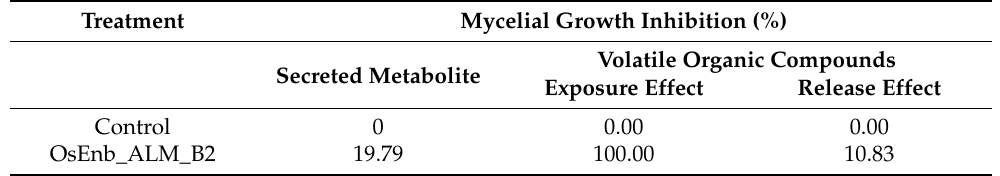
Table 2. Microbacterium -mediated inhibition of Magnaporthe oryzae upon bacterium–fungus interaction.